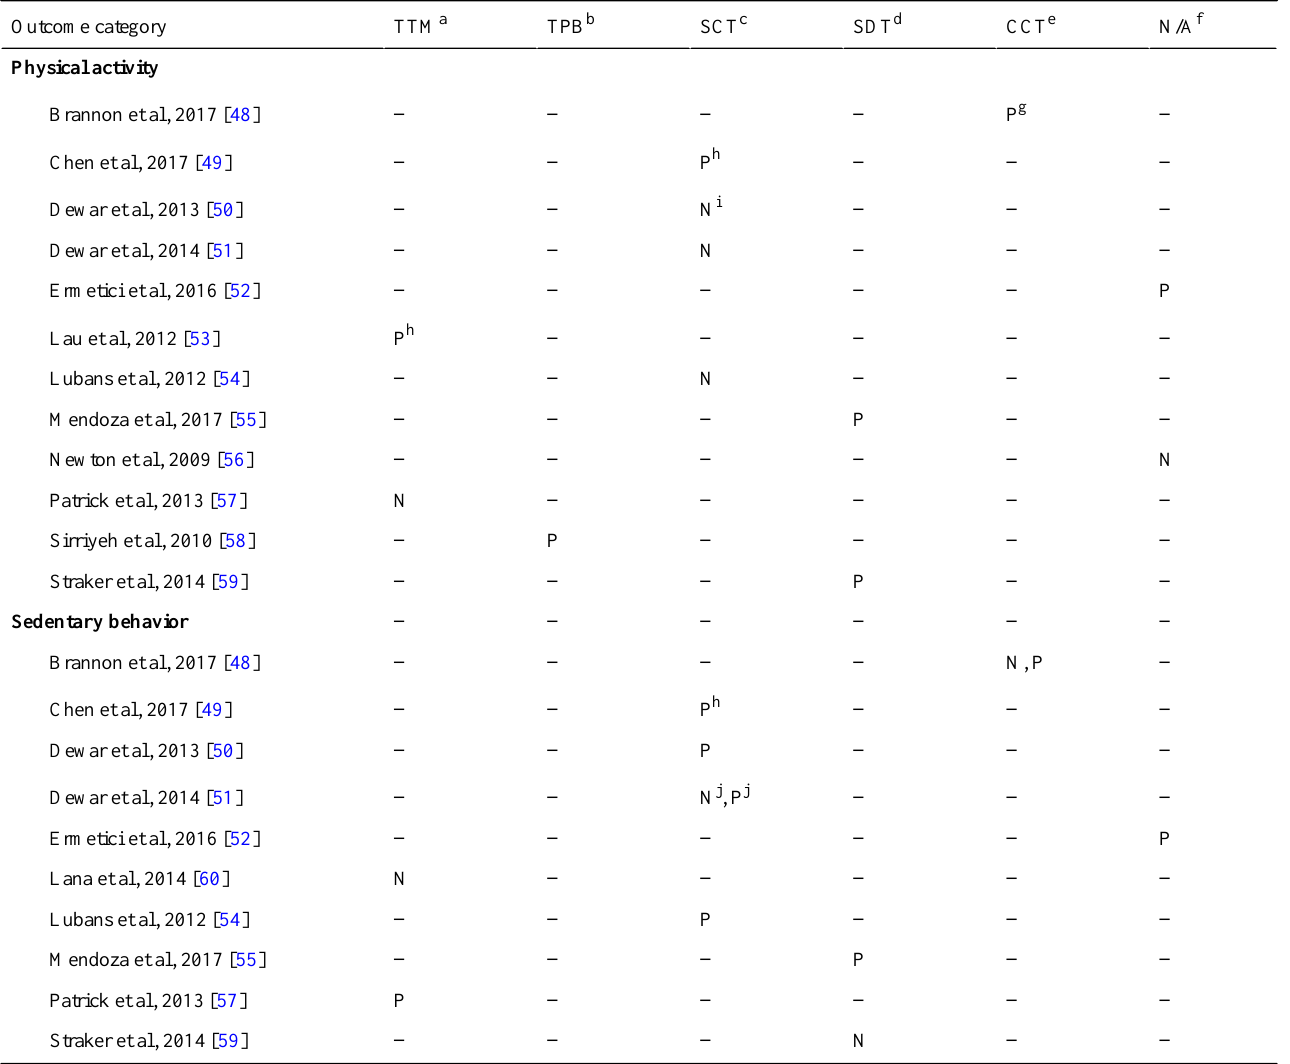
Table 7. Theoretical framework and intervention effectiveness for intervention group at longest follow-up for individual